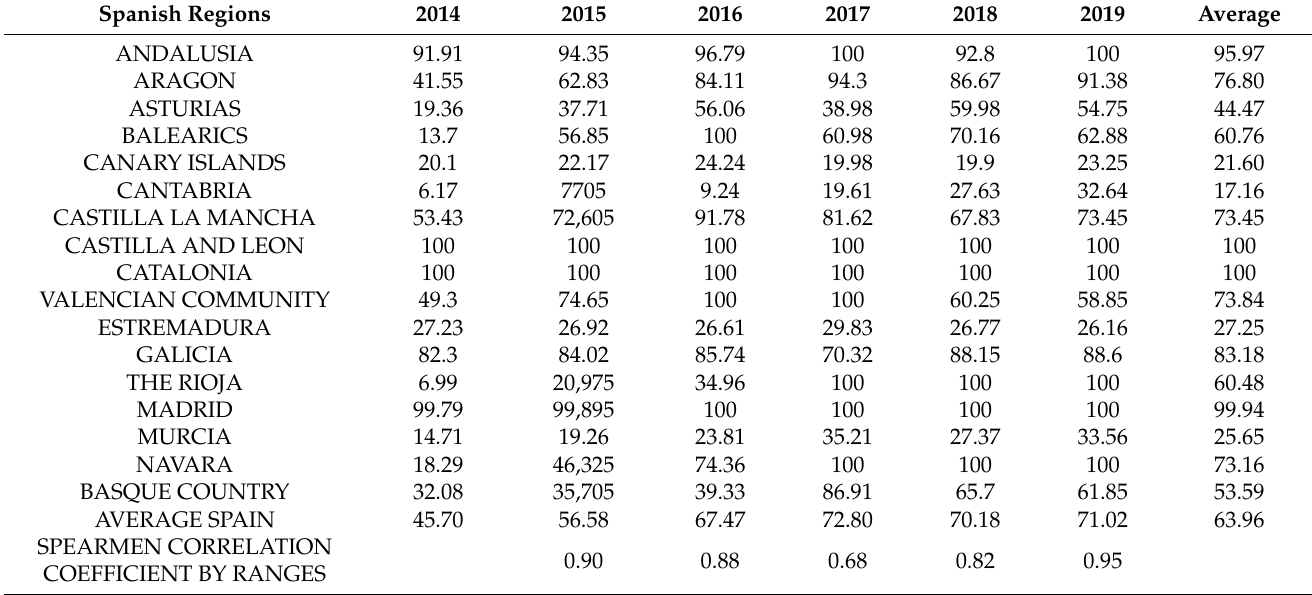
Table 5. Level of energy efficiency of the regions.